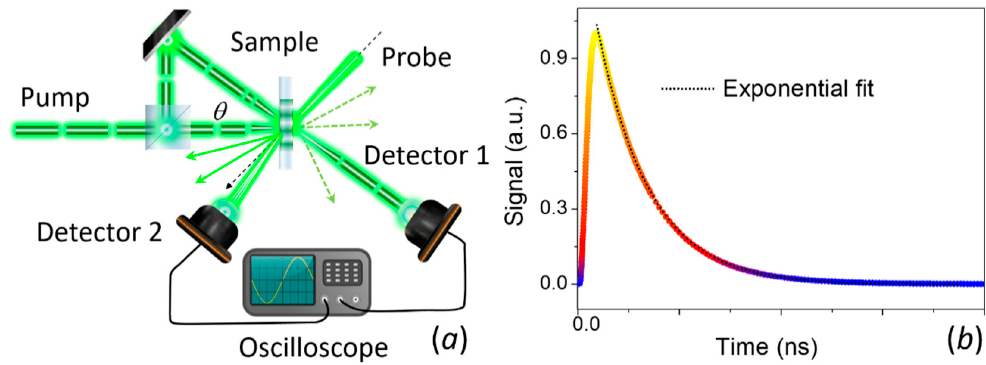
Figure 10. The thermal transient grating technique (TTG). ( a ) Schematic representation of TTG adapted from Eichler et al. [203] and ( b ) artistic representation of a typical signal.